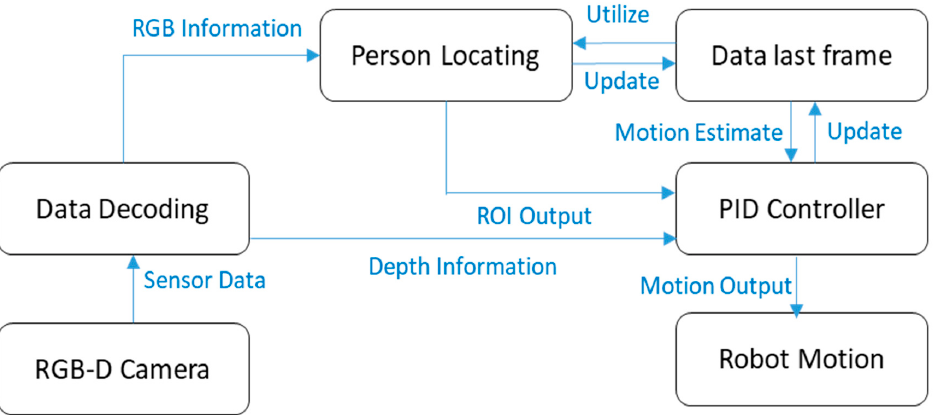
Figure 4. Framework of robot following system.